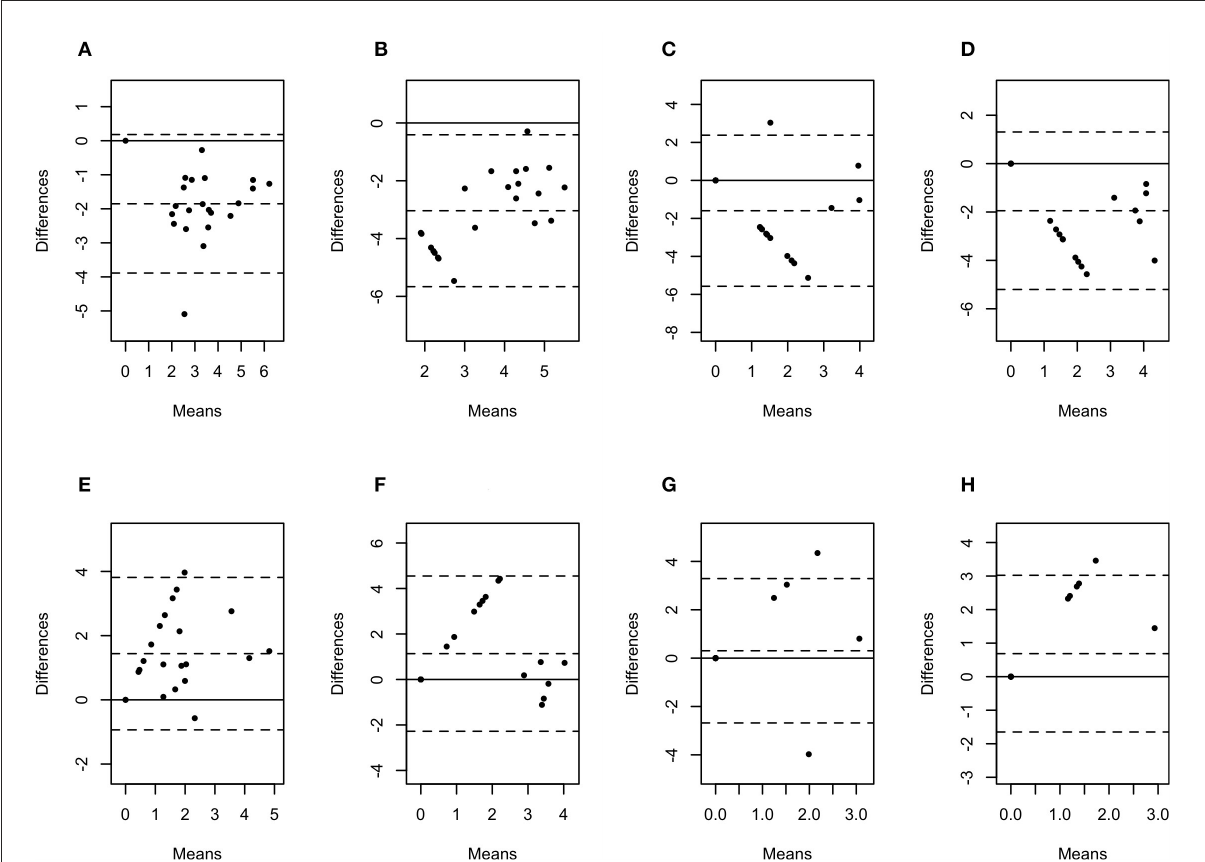
FIGURE6 Bland-Altman plots representing the agreement between the quantity of Porphyromonas levii (A) , Bacteroides pyogenes (B) , Fusobacterium necrophorum (C) , and Fusobacterium mortiferum (D) in biopsies and swabs, and P. levii (E) , B. pyogenes (F) , F. necrophorum (G) , and F. mortiferum (H) in biopsies and aspirates. The center dotted represents the mean of difference (bias), and the two contiguous dotted lines represent the upper and lower limit of 95% of agreement. The solid line crossing the axis at zero represents no difference between the sampling methods (perfect agreement; bias =